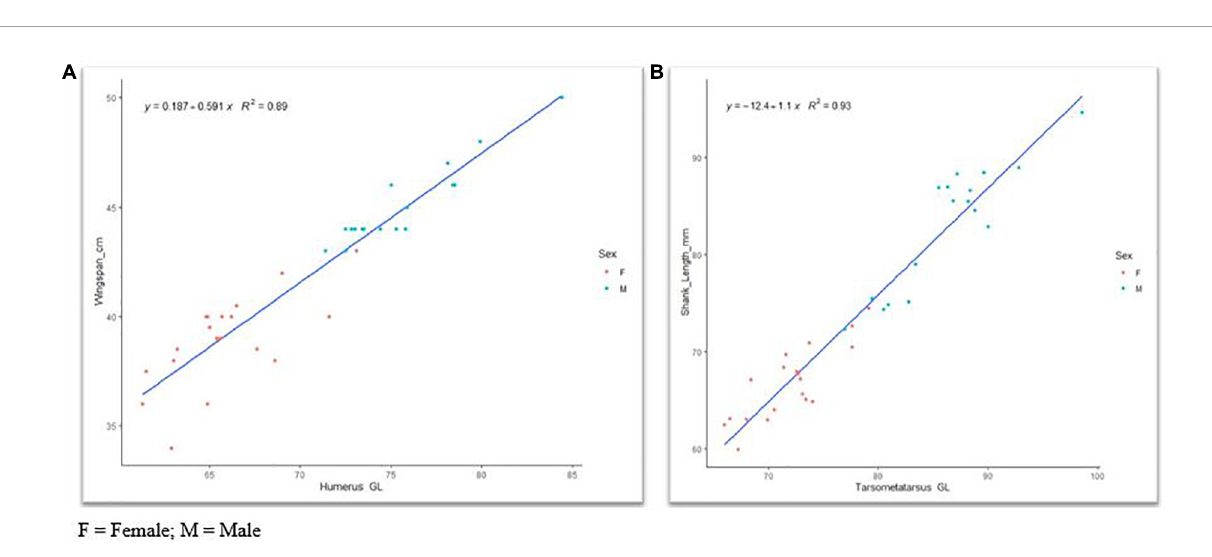
( Supplementary Tables 12A, 13A ), supporting their